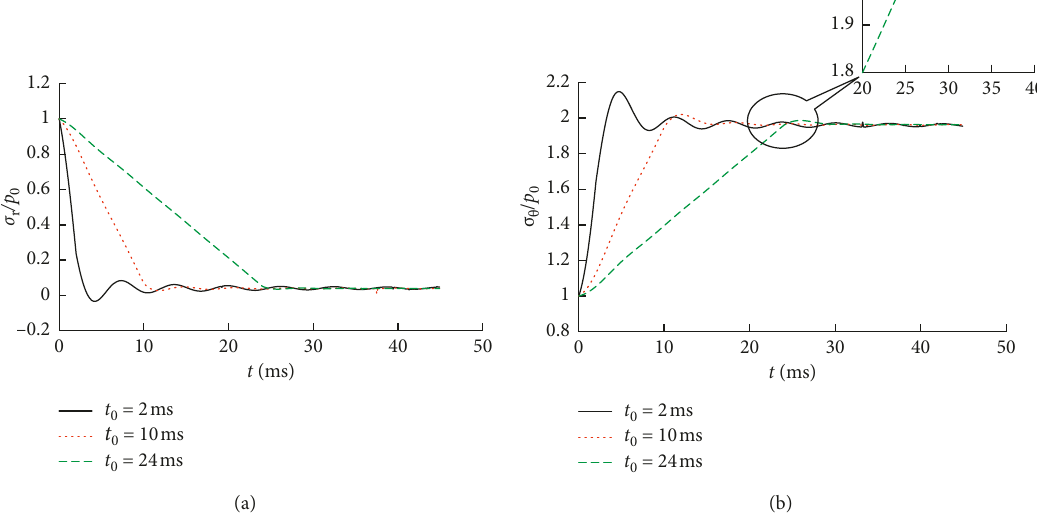
Figure 6: Analytical solution to time history of stress for different unloading durations (at r � 5.1m and p and (b) tangential stress.